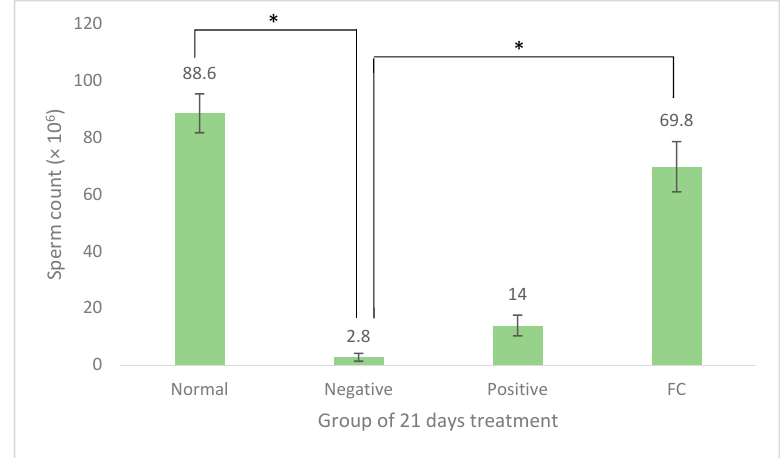
Figure 2. Sperm count (× 10 6 ) of rats from normal (normal group with distilled water), negative (diabetic group with distilled water), positive (diabetic group with 300 mg/kg metformin), and FC (diabetic group with 400 mg/kg Ficus carica aqueous extract). Symbol “ * ” represents significant difference ( p < 0.05).